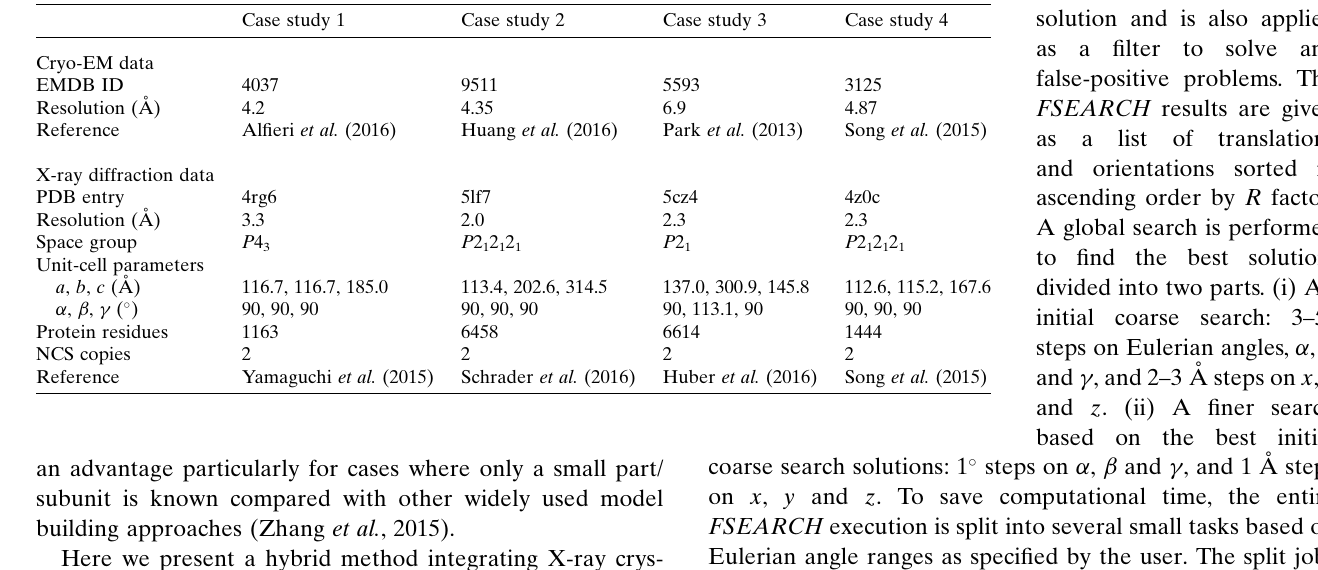
Table 1 Cryo-EM and X-ray diffraction data used in the case